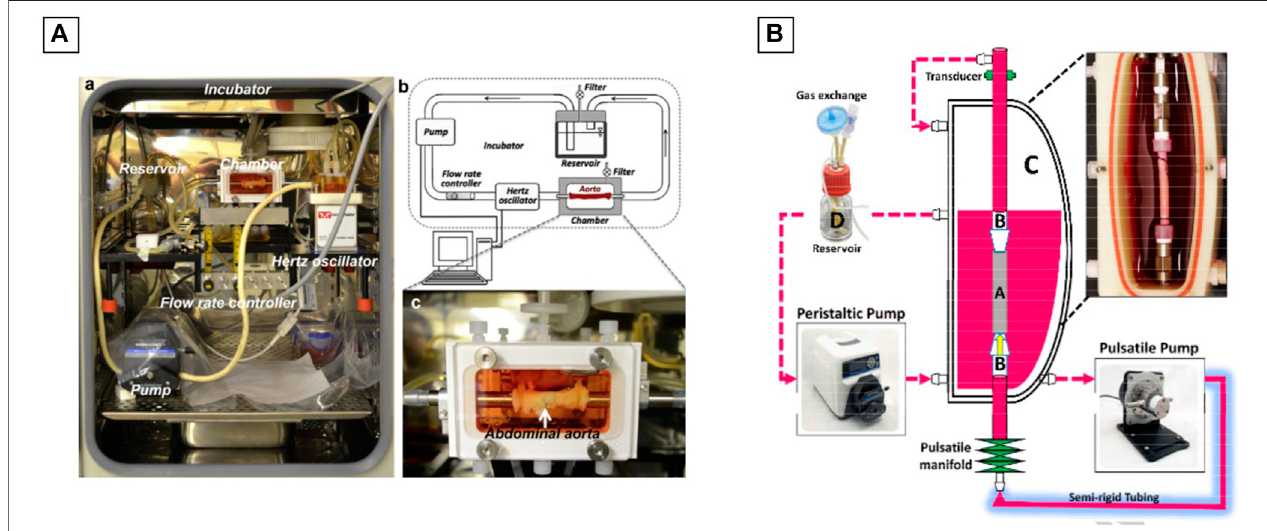
FIGURE8| Commercialbioreactorsconception. (A) TheLumeGen biorectordesign; (B) TheElectroForce ® biorectordesign. Theimage isadapted fromthework of Wang J. et al. (2017) and Lin and Mequanint (2017).